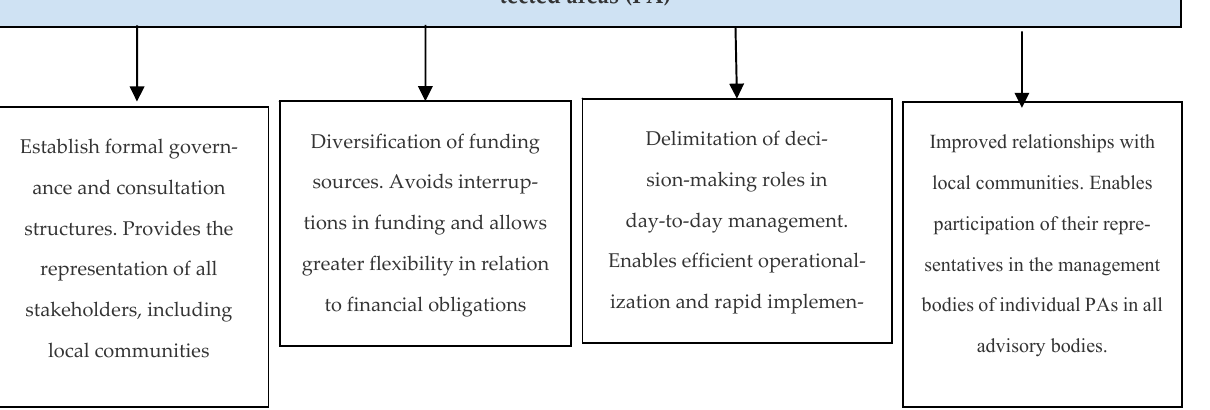
Figure 4. Determinants of PPP functioning in protected area management practices. Source: Prepared according to the work of (Lausche and Burhenne 2011; Brugière 2020).